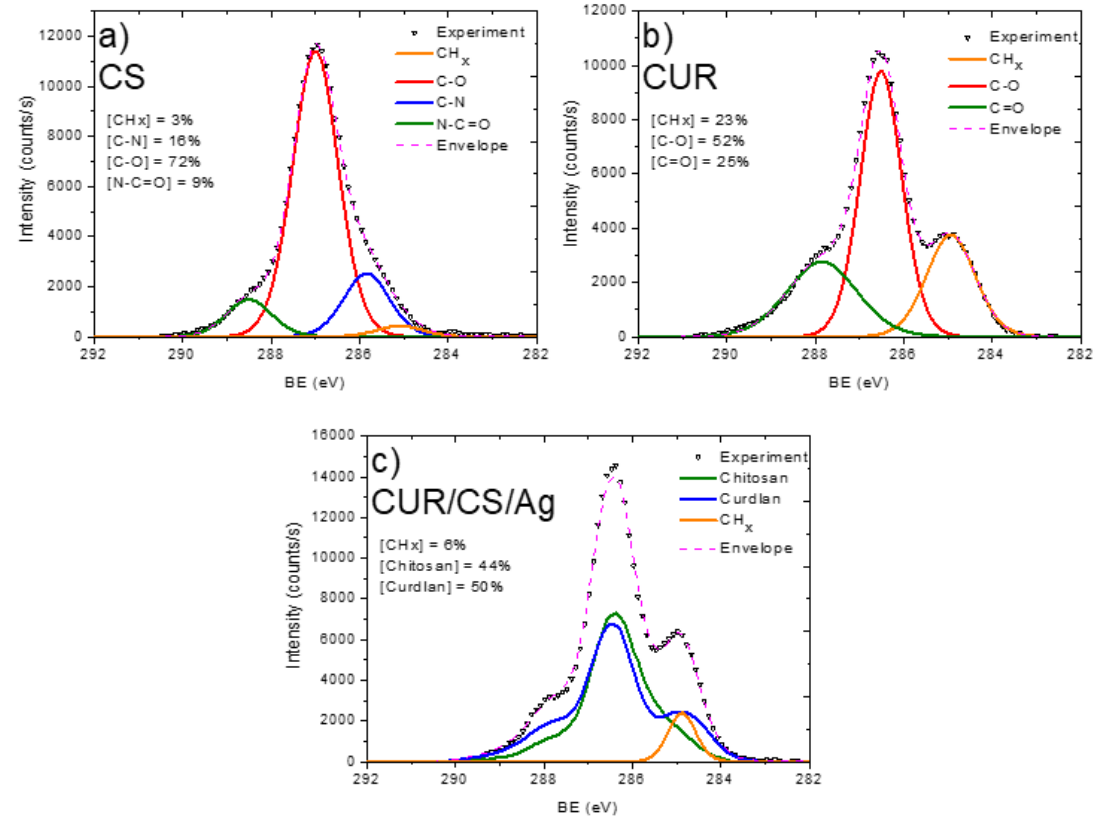
Figure 4. XPS C1s curve fitting of CS ( a ), CUR ( b ), and CS-CUR-Ag ( c ).